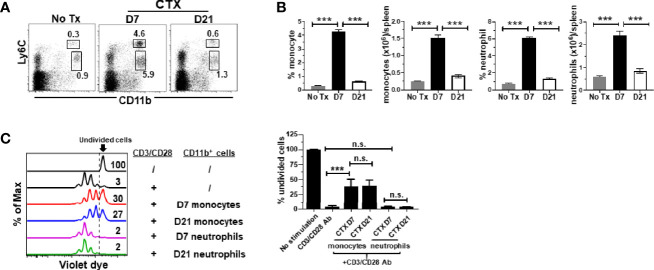
Monocytes from CTX-treated mice retain suppressive activity even after myeloid cell homeostasis is restored. CTX was given to naïve Balb/c mice either 7 or 21 days prior to cell harvest. Spleen cells were collected and stained for CD11b and Ly6C. (A) Representative dot plots are shown, and the numbers indicate the frequencies of gated populations. The results are summarized in bar graphs with at least three mice each group (B). The formula for cell number calculation is: total cell number x percent of specific myeloid cell subset. (C) In vitro suppression assay. In vitro suppression culture was setup as described in Figure 2. Equal number of responder cells and sorted myeloid cells were used. Proliferation of responder T cells was evaluated by violet dilution. Numbers in histogram indicate the percent of undivided responder T cells. The frequencies of undivided responder T cells under each culture condition shown as mean ± SD of triplicate cultures are summarized in the bar graph on the right. Data shown are representative of two independent experiments. n.s., not significant, ***p < 0.001.